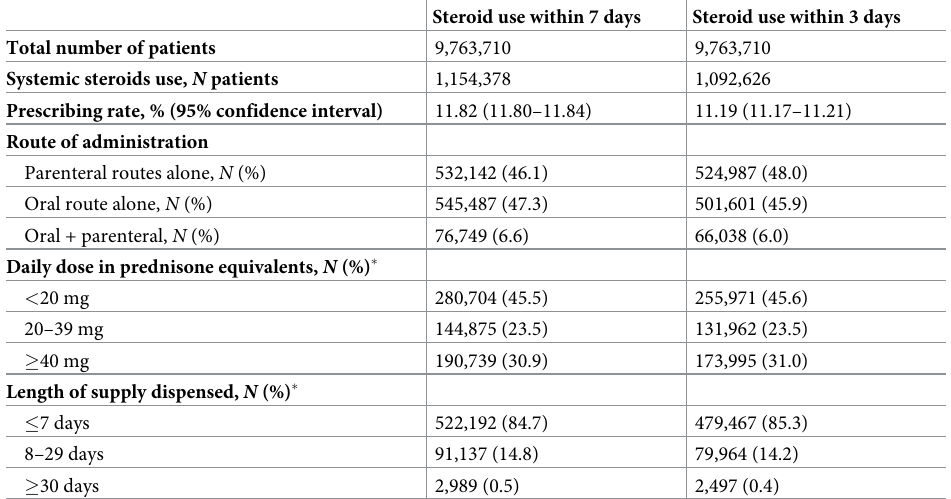
Table 1. Steroid use for ARTIs.